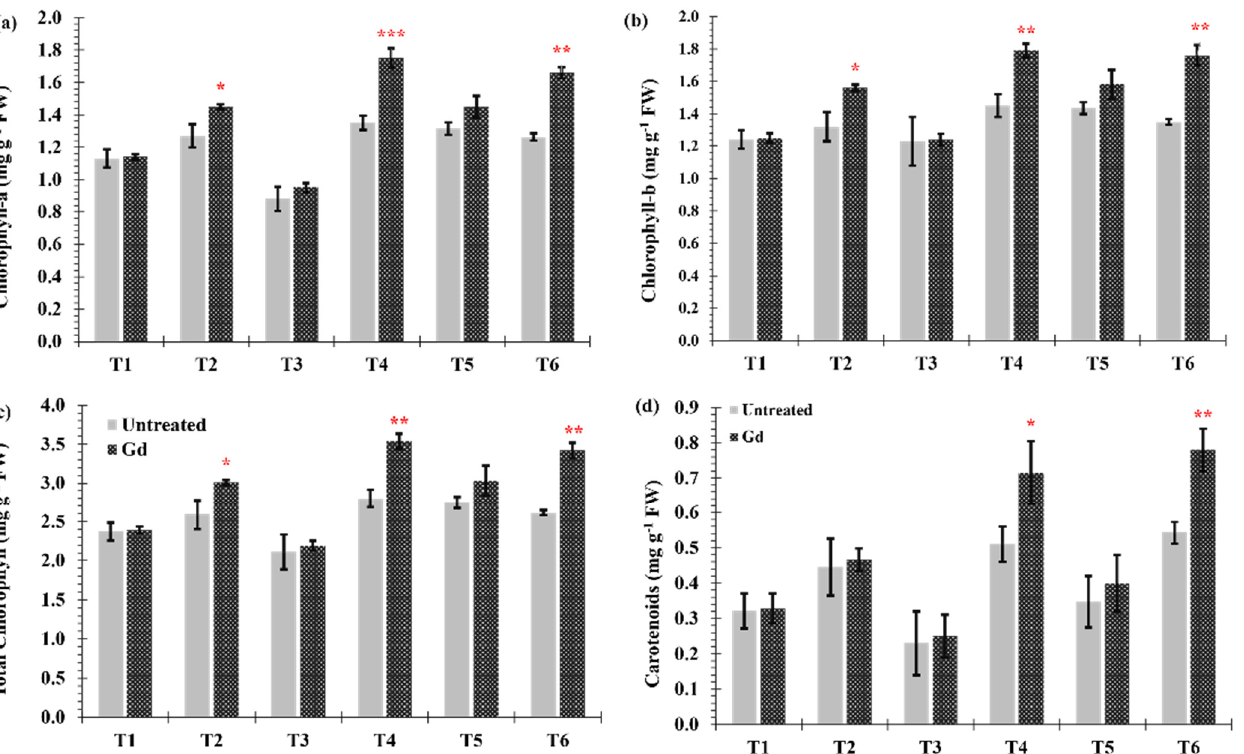
Figure 4. Evaluating the effects of severe water stress (35%-WHC; T1), moderate water stress (50%-WHC; T2), severe nitrogen stress (0 mg N pot − 1 ; T3), moderate nitrogen stress (150 mg N pot − 1 ; T4), combination of severe water stress and moderate nitrogen stress (35% WHC and 0 mg N pot − 1 ; T5), and combination of moderate water stress and moderate nitrogen stress (50% WHC and 150 mg N pot − 1 ; T6) on ( a ) Chlorophyll-a and ( b ) Chlorophyll-b, ( c ) total Chlorophyll and ( d ) carotenoids of maize plants inoculated with Gluconacetobacter diazotrophicus Pal5 (Gd) in comparison with untreated plants. Chlorophyll is shown in milligram per gram of fresh weight (mg·g − 1 FW) of plants. Bars represented means of three ( n = 3) replicates with standard errors (SEs). *, ** and *** above bars indicate significance at p < 0.05, p < 0.01 and p < 0.001, respectively. Bars without any * are non-significant ( p > 0.05).